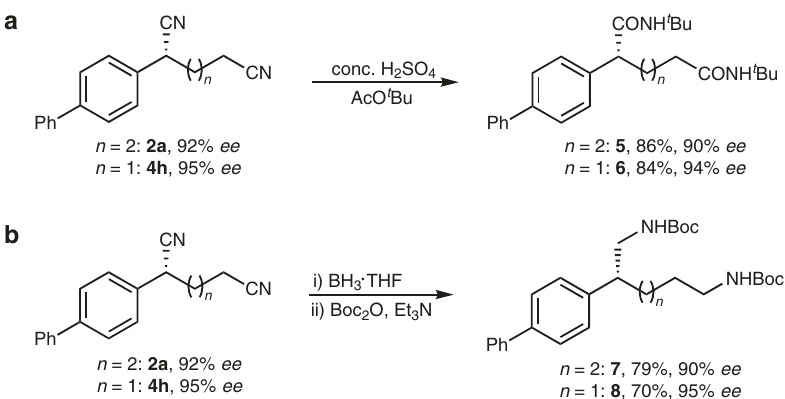
Fig. 4 Synthetic applications. a 2a or 4 h was converted to chiral diamides. b 2a or 4 h was converted to chiral diamines. Boc 2 O Di- tert -butyl decarbonate.